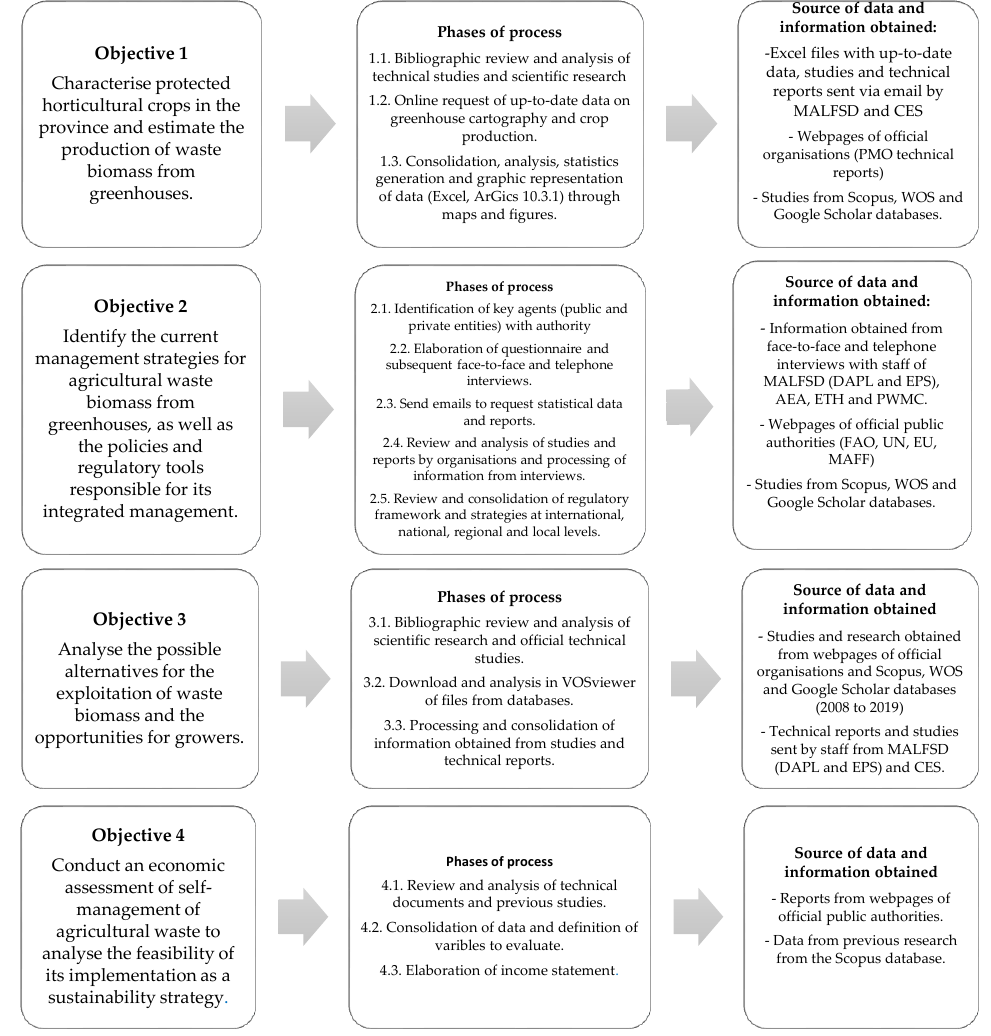
Figure 1. Stages of the study elaboration process by objective. MALFSD: Ministry of Agriculture, Livestock, Fisheries and Sustainable Development of the Regional Government of Andalusia, DAPL: Department of Agricultural Production and Livestock, EPS: Environmental Protection Service, PMO: Prices and Markets Observatory, AEA: Andalusian Energy Agency, CES: Cajamar Experimental Station, PWMC: Plant Waste Management Companies, ETH: El Ejido Town Hall, FAO: Food and Agriculture Organization of the United Nations, UN: United Nations, EU: European Union, MAFF: Ministry of Agriculture, Fisheries and Food.